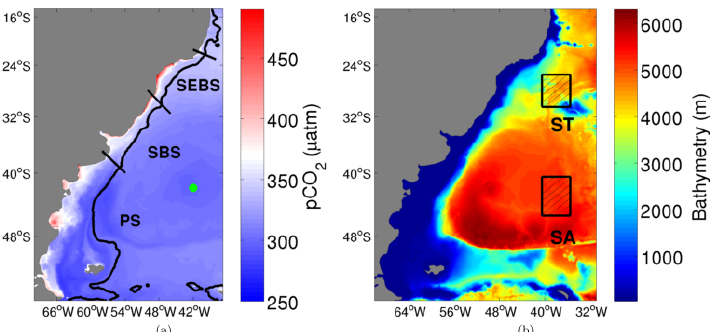
Figure 1. Areas utilized for the temporal analysis, (a) shows the three continental shelves (SEBS, SBS and PS) analyzed in a map with annual mean ocean surface p CO 2 . The green circle represents the location of the vertical profile at the OOI site. (b) shows the two oceanic regions (ST and SA) in a map with